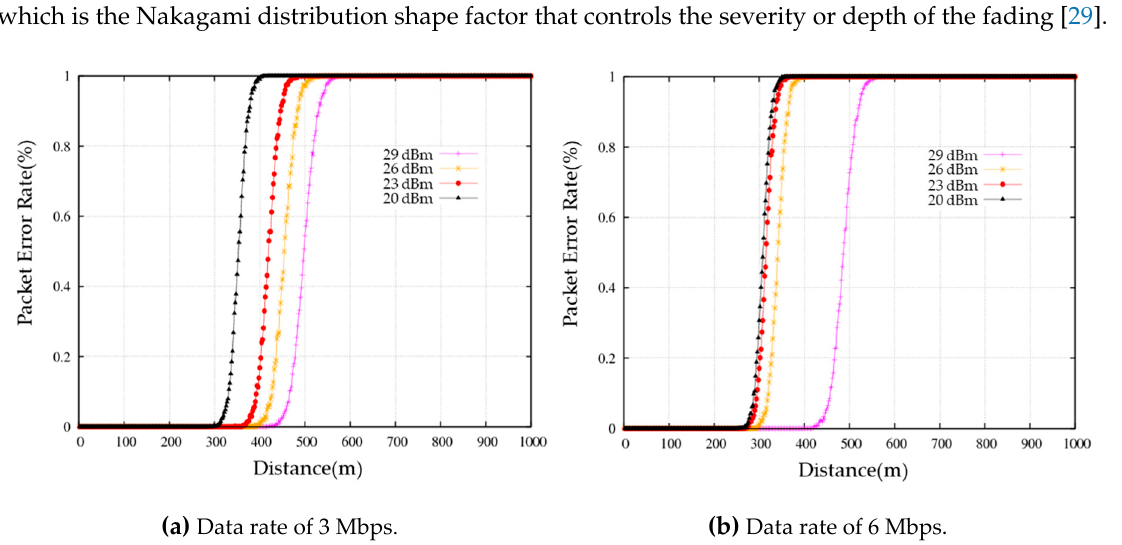
Figure 7. Packet error rate of V2X communication channel in the urban LOS environment.